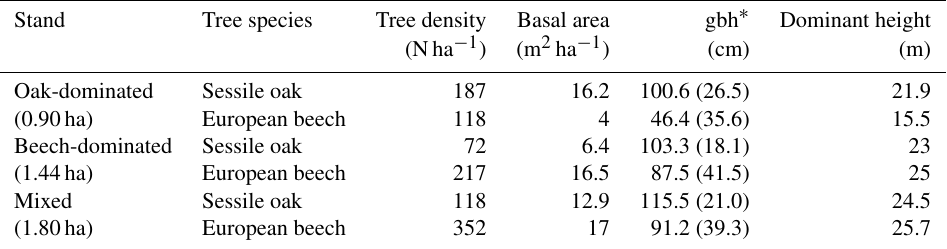
Table 1. Stand characteristics for the main tree species derived from stand inventories in 2001. Standard deviation is provided in parentheses. Stand Tree species Tree